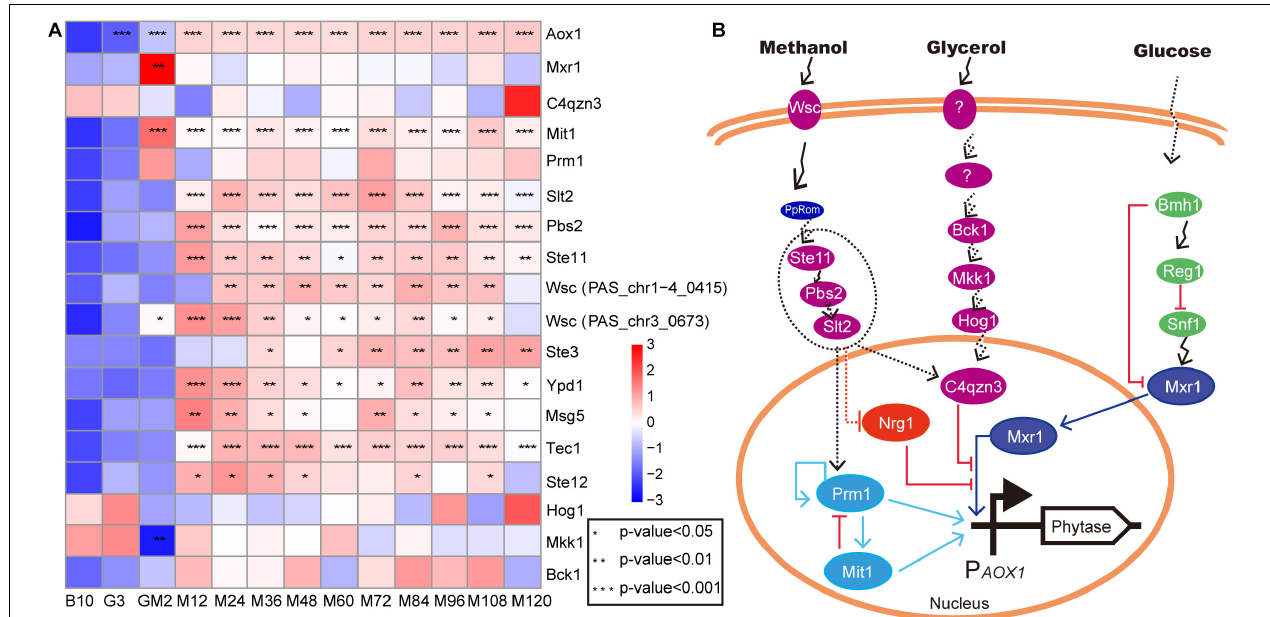
FIGURE 5 | The upregulated genes of MAPK signal pathway involve in cell growth. (A) heat map of related genes involved in cell growth and AOX1 promoter regulation. (B) the predicted regulatory relationships for the AOX1 promoter. The proteins in the dashed ellipse represent proteins that are due to be knocked out and overexpressed in subsequent verification experiments. The methanol regulatory relationship predictions were generated during this study, while the predictions for glycerol (Shen et al., 2016) and glucose (Parua et al., 2012) were reported by other researchers. Purple represents the protein in the MAPK pathway, the dotted line indicates the possible relationship, and the solid line indicates the experimentally validated